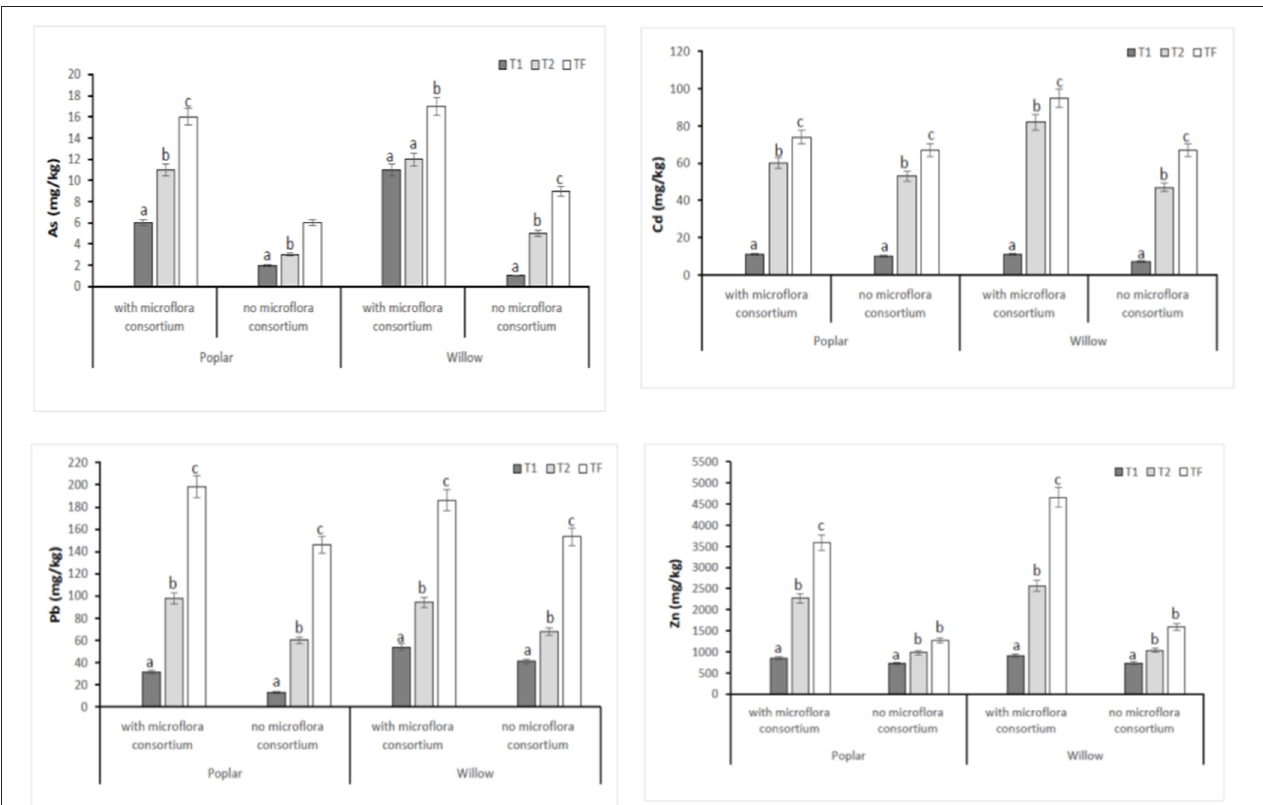
FIGURE 5 | Total concentration of HMs (As, Cd, Pb, and Zn) in areal part (shoots and leaves) at different monitoring time (T 0 :0, T 1 :12, T 2 :24 and T F : 36 months) with microflora consortium and no microflora consortium in hybrid poplar Populous deltoids × Populous nigra and in willow Salix purpurea subsp. lambertiana . Mean values ±